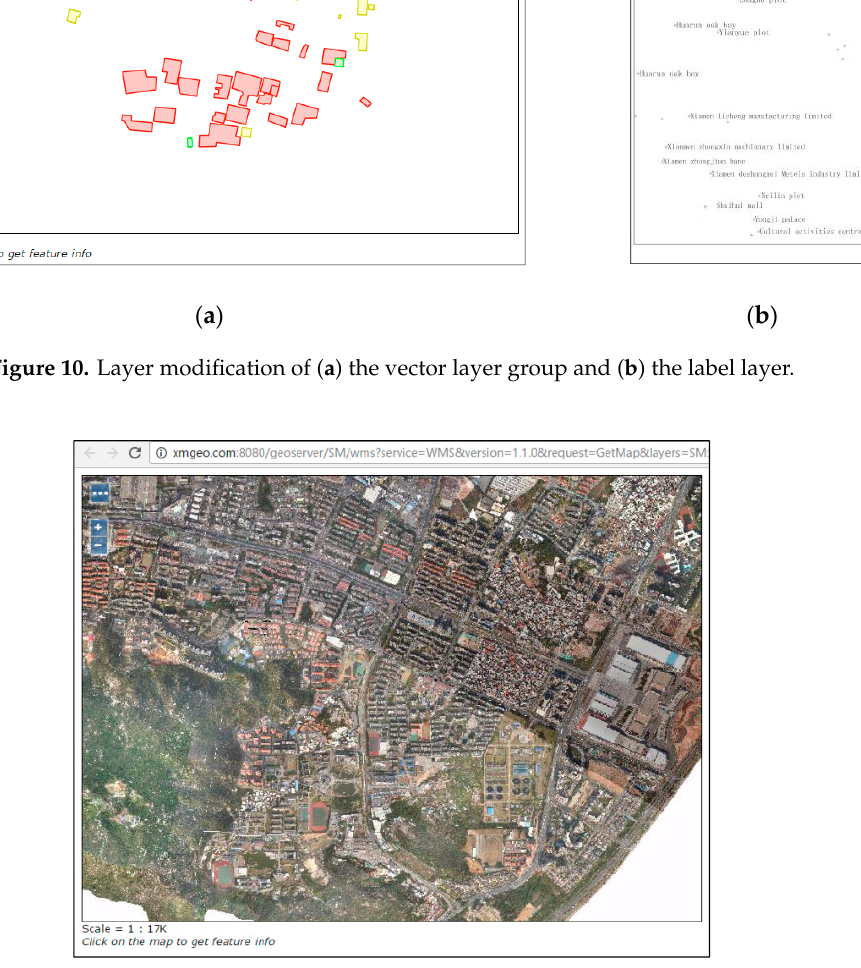
Figure 12. Vector layer release. 6. Grid Management Mobile System Construction 6.1. Function Design of Grid Management on Mobile Terminal System As grid management has become routine, large-scale, and unevenly distributed, it is necessary to introduce mobile terminals as information support tools for daily operations, to prepare grid managers for timely on-site data collection and analysis. The system framework of the mobile law enforcement platform for illegal constructions mainly consists of three parts, namely, mobile terminal, PC terminal, and server. The functions of the mobile terminal include main functions such as home page, grid task, illegal construction record, location navigation, and opinion feedback. The PC terminal accesses the monitoring system through the browser, mainly for data management and display and task distribution and management of the mobile terminal, so that law enforcement